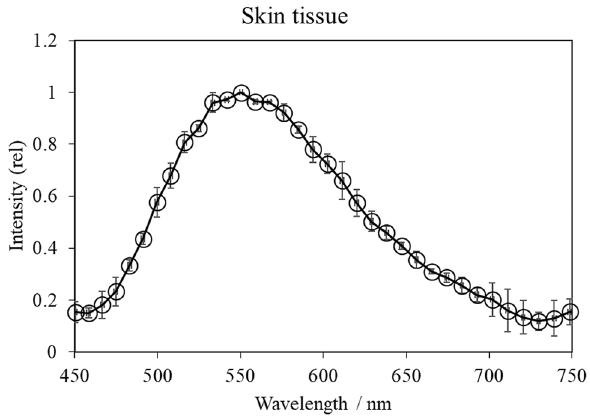
Figure 1. UVA-induced UPE spectrum of the skin tissue. Human skin tissue was irradiated with UVA (1100 mJ/cm 2 ) and UPE spectra were measured using a spectroscopy system. The UPE intensity was normalized by the intensity at the peak wavelength and is displayed as relative intensity (rel). Data are presented as means ± SD (n =